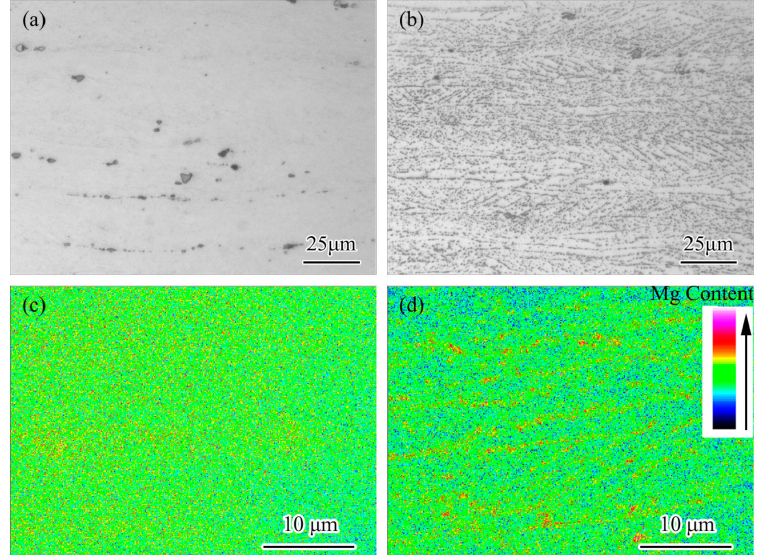
Figure 3. ( a , b ) Optical microstructure and ( c , d ) element distribution (analyzed by electro n -probe microanalysis (EPMA)) of Al–10Mg alloy annealed at ( a , c ) 200 ◦ C and ( b , d ) 300 ◦